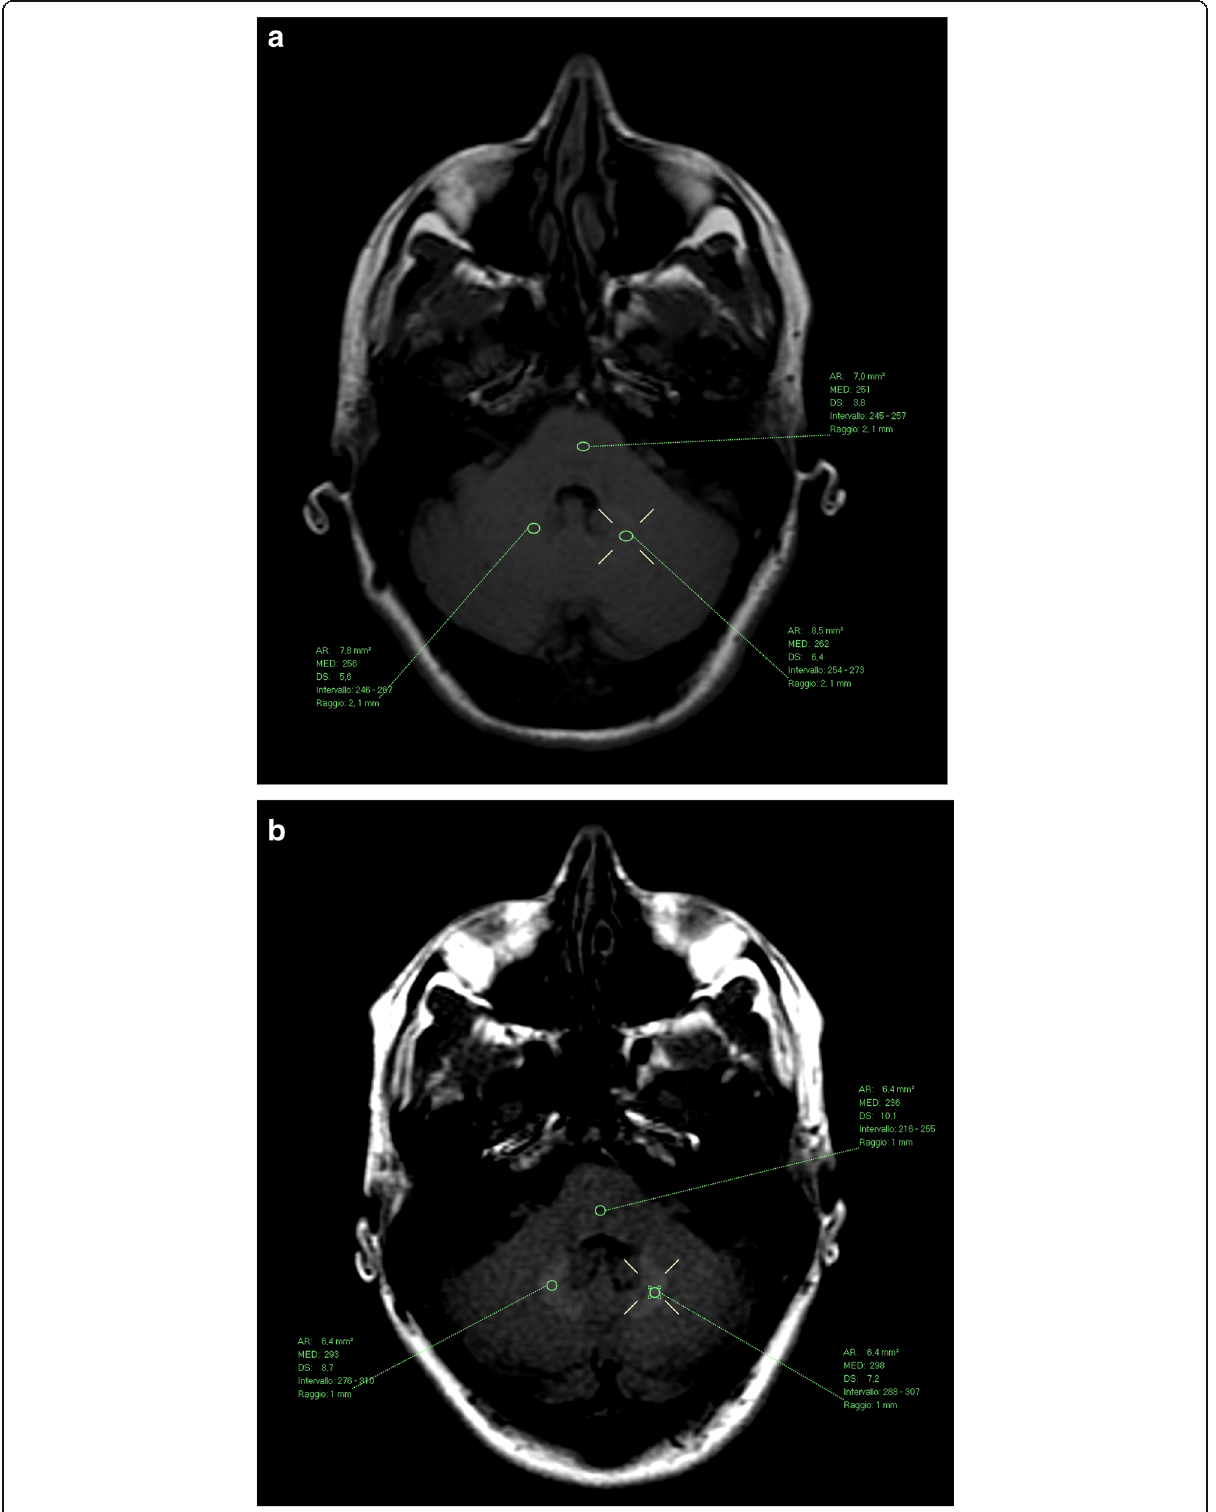
Fig. 2 Female patient, 49 years old, before ( a ) and after ( b ) 11 administrations of gadobutrol. The mean DN/P SI ratio increased from 1.03 at the first exam in March 2006 to 1.25 at the last exam in July